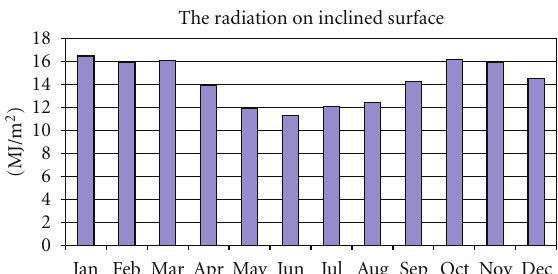
Figure 7: The solar radiation data for BH city (in MJ/m 2